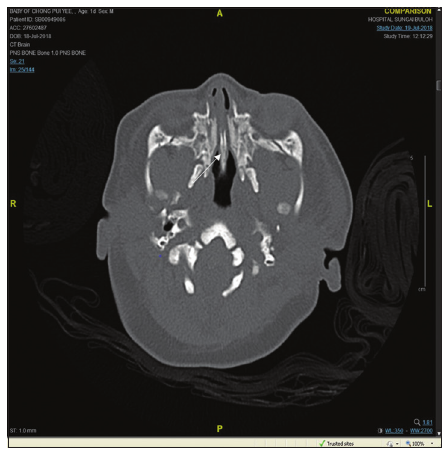
FIGURE 1. Axial view of computerized tomography scan shows a stenosed nasal cavity with thickened vomer (arrow).